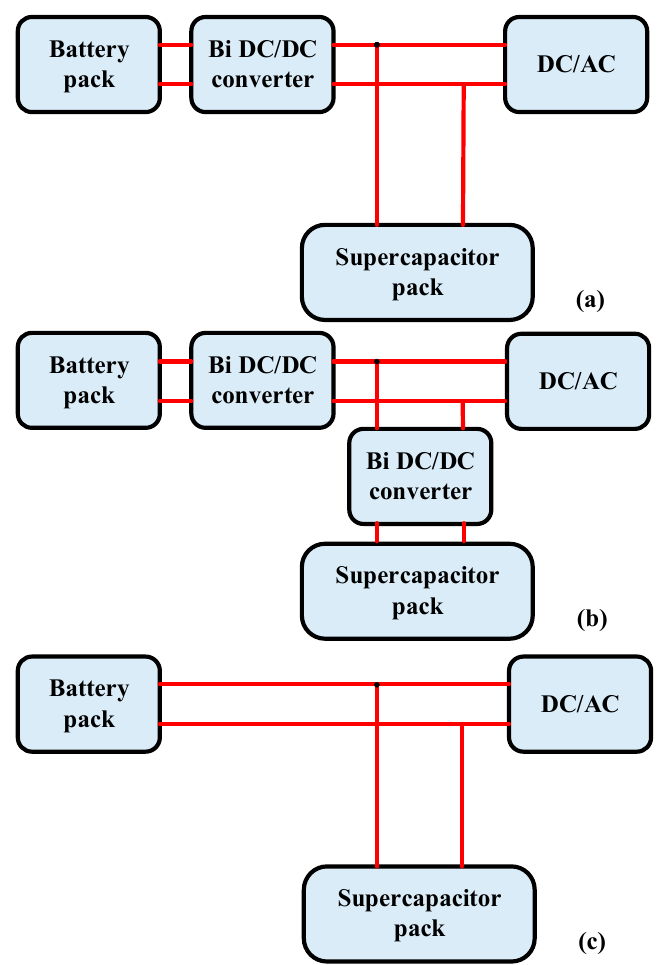
Figure 1. HESS topologies. ( a ) Semi-active; ( b ) fully active; ( c ) passive parallel.